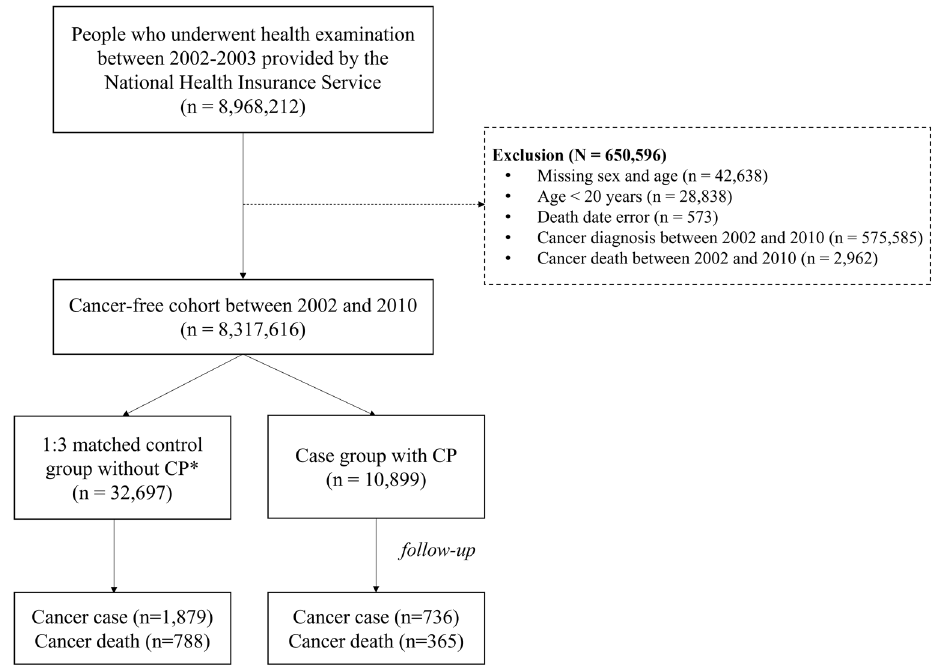
Figure 2. Flowchart of the study population. * Free of chronic pancreatitis for the whole study